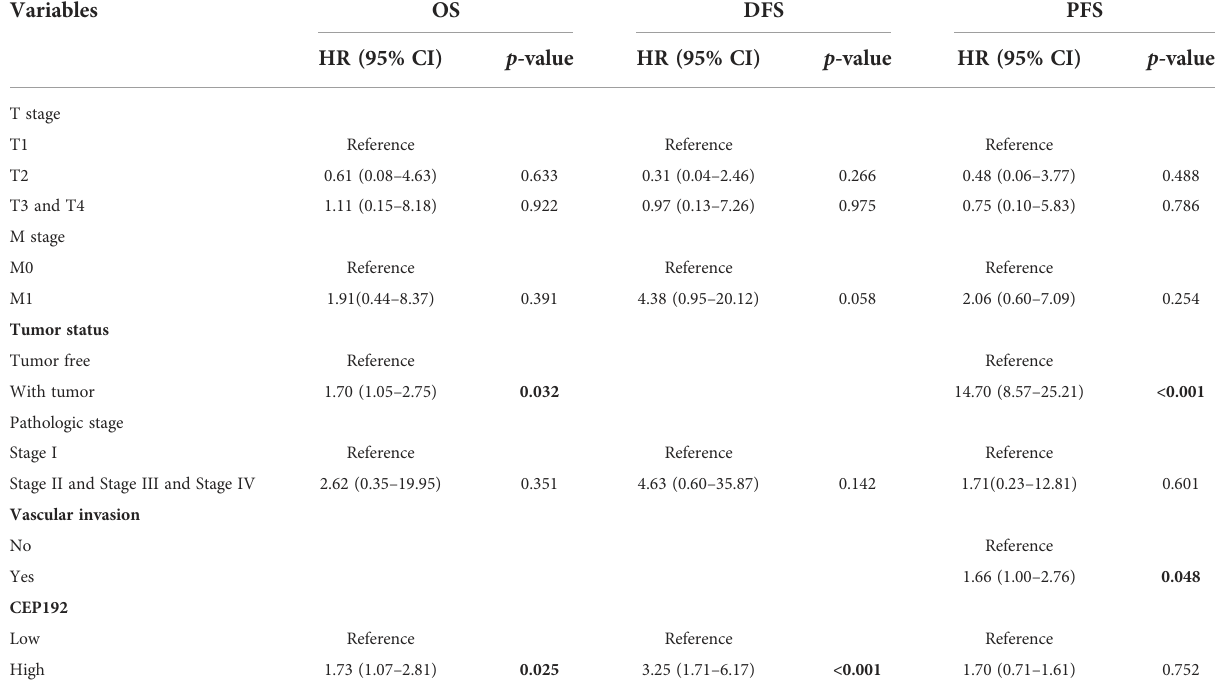
TABLE 3 Multivariate Cox proportional hazard models for overall survival (OS), disease-free survival (DFS), and progression-free survival (PFS) in HCC patients.